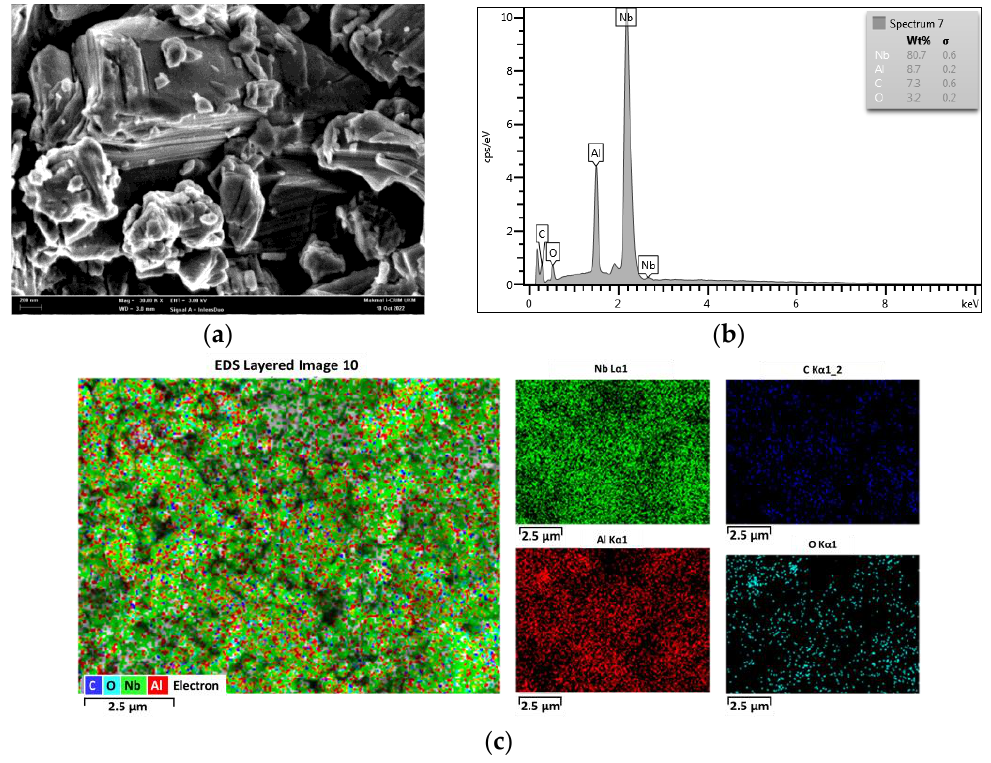
Figure 4. Characterisation of Nb 2 AlC ( a ) FESEM image of Nb 2 AlC-PVA film at 200 nm scale ( b ) EDX analysis with Nb, Al, C, and O elements ( c ) Mapping of Nb 2 AlC nanoparticles.